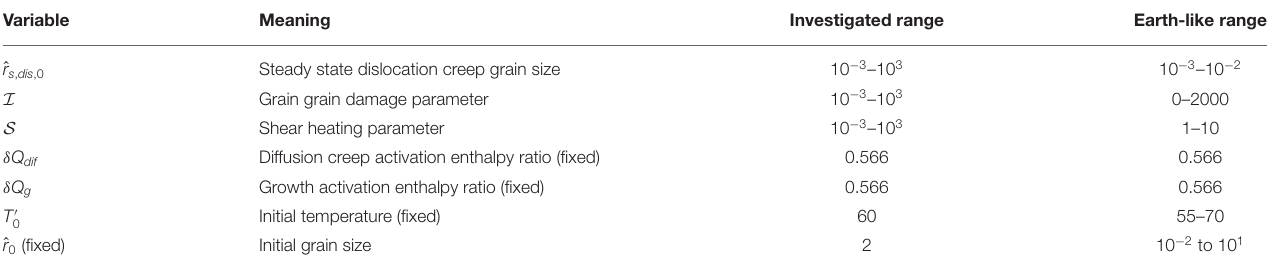
TABLE 2 | Nondimensional model parameters and parameter ranges computed with the material parameters given in Table 1 and for slab lengths H of 100–500 km, average slab temperatures T of 900–1,200 K, pressures of 3–9 GPa, and partitioning factors λ I ranging from 10 − 6 to 10 − 3 . Variable